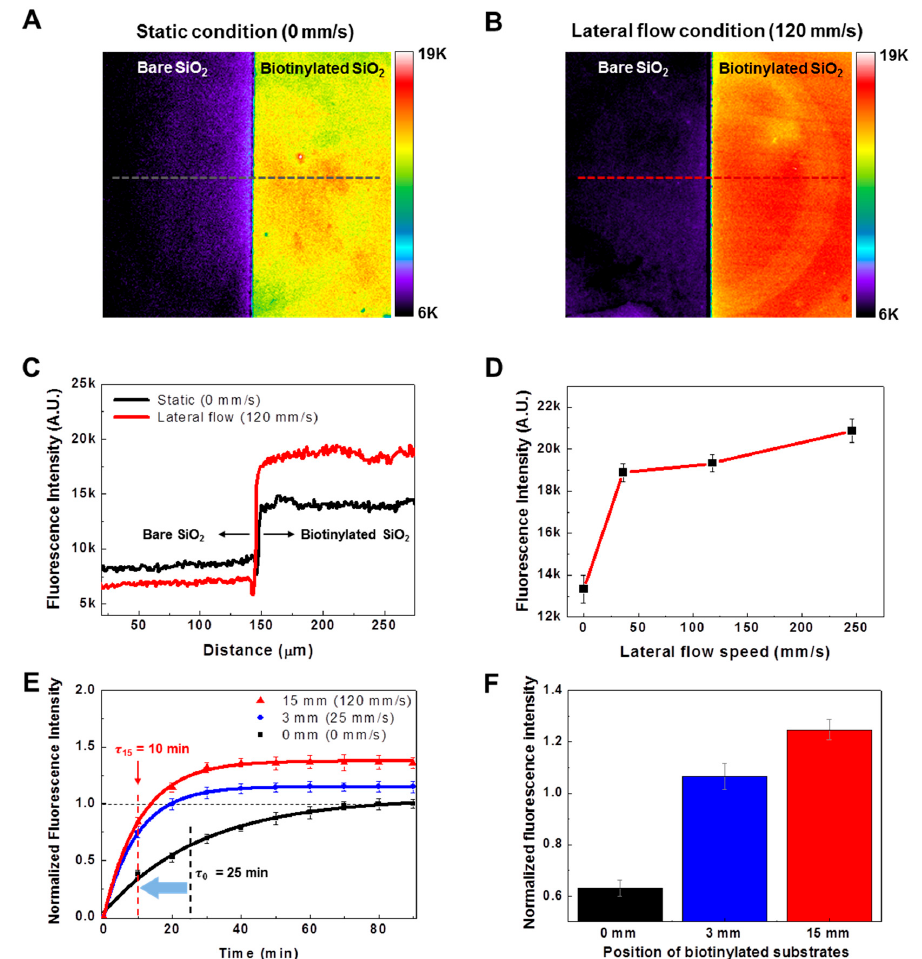
Figure 2. Effect of lateral flows on binding reactions between a biotinylated SiO 2 substrate and streptavidin molecules: ( A ) Fluorescence images of bare and biotinylated SiO 2 substrates after reaction with FITC-labeled streptavidin molecules under static conditions; ( B ) Fluorescence images of bare and biotinylated SiO 2 substrates after reaction with FITC-labeled streptavidin molecules under lateral flow conditions; ( C ) Comparison of amount of bound streptavidin molecules on a bare and a biotinylated SiO 2 substrate with and without lateral flow (120 mm/s). The fluorescence profiles were obtained from the fluorescence images of Figure 1A,B.; ( D ) Fluorescence intensities of biotinylated substrates after reaction with FITC-labeled streptavidin molecules under lateral flow speeds of 0, 30, 120 and 250 mm/s; ( E ) Real-time fluorescence measurement data obtained from biotinylated substrates during reaction with FITC-labeled streptavidin molecules. The biotinylated substrates were fixed to a rotating disk at 0, 3 and 15 mm from the center of the disk.; ( F ) Fluorescence intensities of bound FITC-labeled streptavidin molecules on biotinylated substrates attached at different positions on the rotating disk. The fluorescence intensities were obtained at the reaction time of 25 min in Figure 1E.